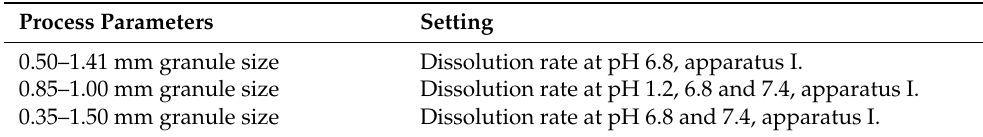
Table 1. The process parameters used in the dissolution studies. Process Parameters Setting Dissolution rate at pH 6.8, apparatus